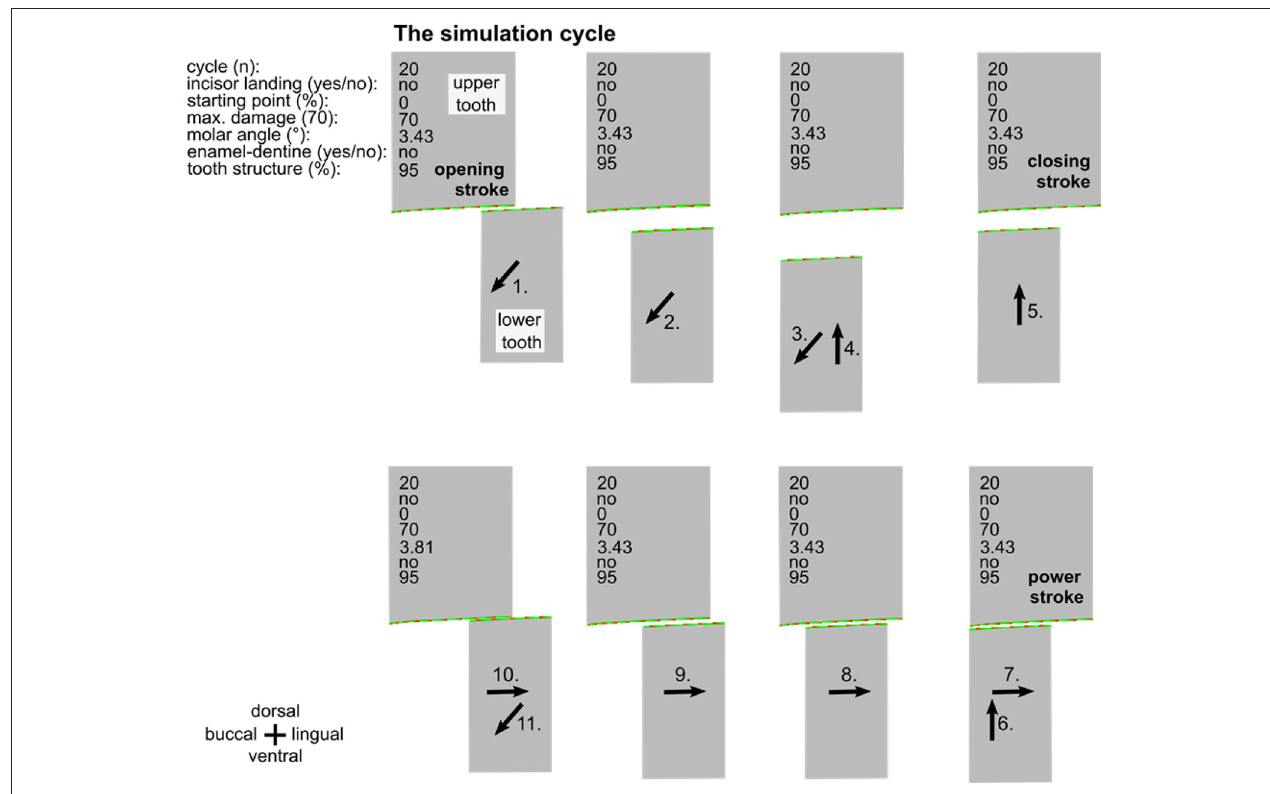
FIGURE 2 | Overview of one entire simulation cycle (no. 20). The simulations consist of the opening stroke (1.-3.), the closing stroke (4.-6.), and the power stroke (7.-10), followed by a subsequent opening stroke (11.). Inscriptions specify the simulation parameters. Black arrows indicate the movement of the lower cheek tooth.